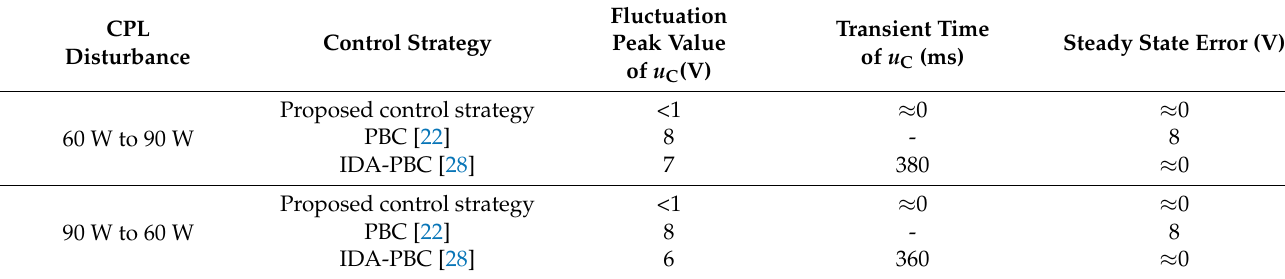
Table 5. Experimental results for u C of DDBC under different control strategies and CPL disturbances. CPL